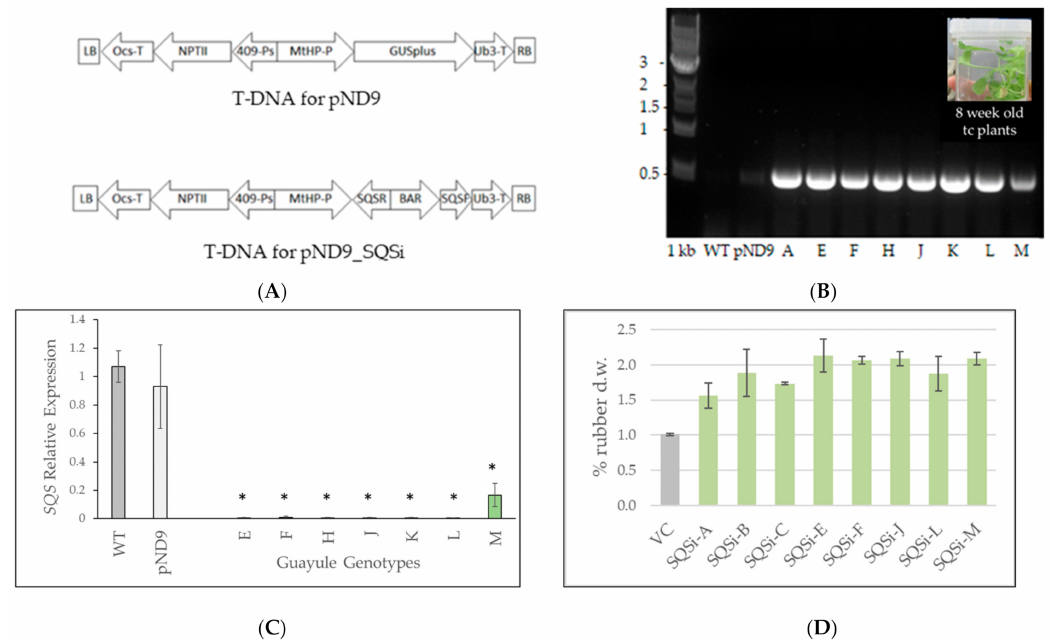
Figure 1. ( A ) T-DNA region of transformation constructs. pND9, β -glucuronidase plus ( GUSPlus ) reporter gene driven by Medicago truncatula promoter (MtHP-P) with ubiquitin 3 terminator (Ub3-T) and a shortened potato polyubiquitin promoter (409-Ps) controlling the expression of the neomycin phosphotransferase II ( nptII ) gene for kanamycin resistance with octopine synthase terminator (Ocs- T). pND9_SQSi, the GUSPlus gene in pND9, is replaced with a hairpin RNAi construct built with two inverted repeats of the partial P. argentatum SQS gene (SQSR and SQSF); a bialaphos resistance ( BAR ) gene was inserted between them. LB, left border, RB, right border. ( B ) Confirmation of transgenic plants. Guayule transgenic plants were confirmed with PCR using genomic DNA as a template. Primers for the BAR gene were used to confirm the guayule plants harboring pND9_ SQS T-DNA. The expected product size is 551 bp in the downregulated lines. ( C ) Quantitative-RT-PCR (qPCR) of stembark tissues. Expression level of 170 bp PCR product in the SQS coding sequence compared with WT. The 18S gene (195 bp) was used as an internal control. The asterisks (*) indicate a significant difference in comparison with WT at p ≤ 0.05. ( D ) Rubber content in tissue-cultured plants, as determined by ASE microassay. WT = G7-11 wildtype; VC = vector control pND9; SQSi-A, -E, -F, -H, -J, -K, -L, and -M represent independent gene downregulation